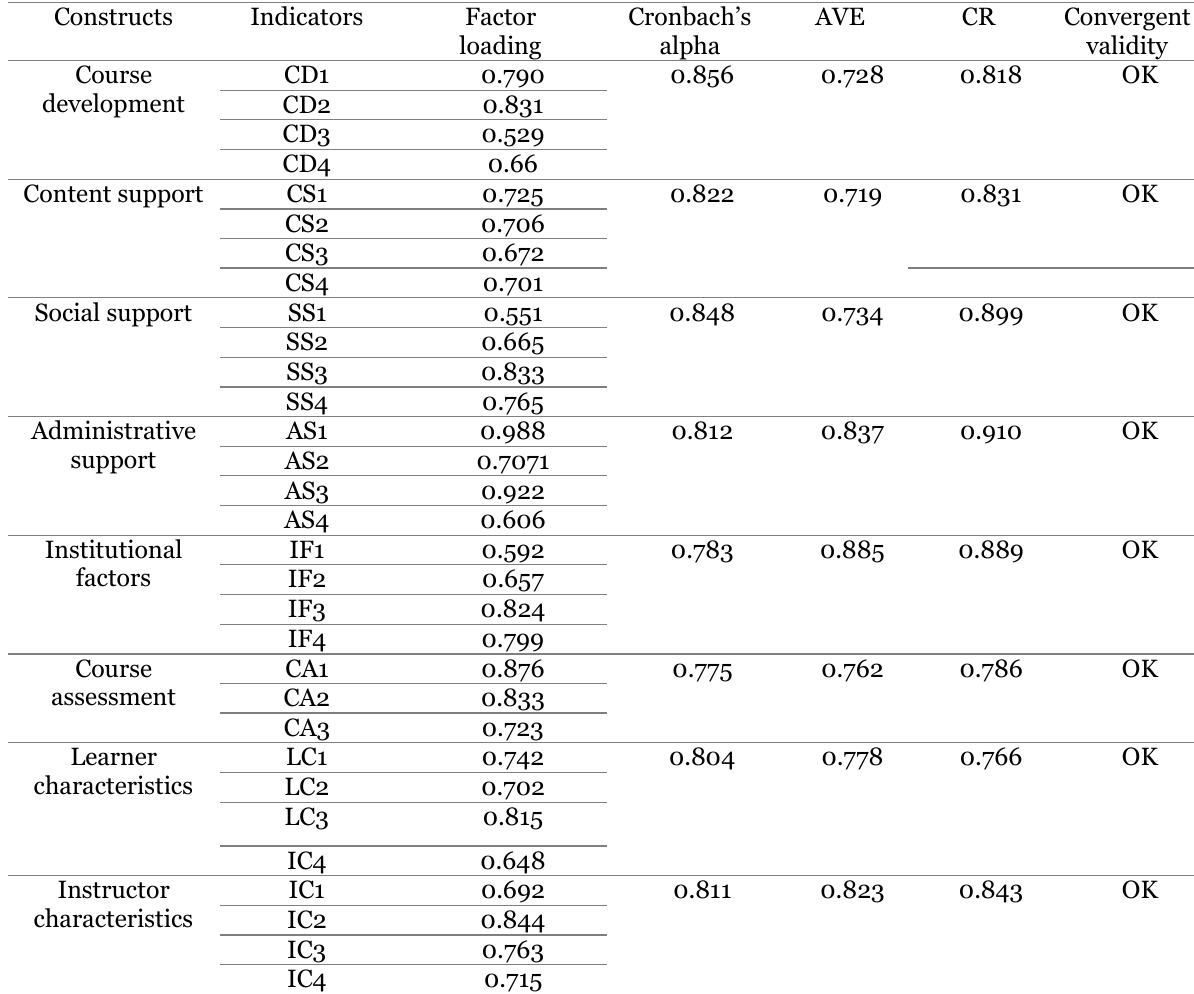
Reliability and Convergent Validity